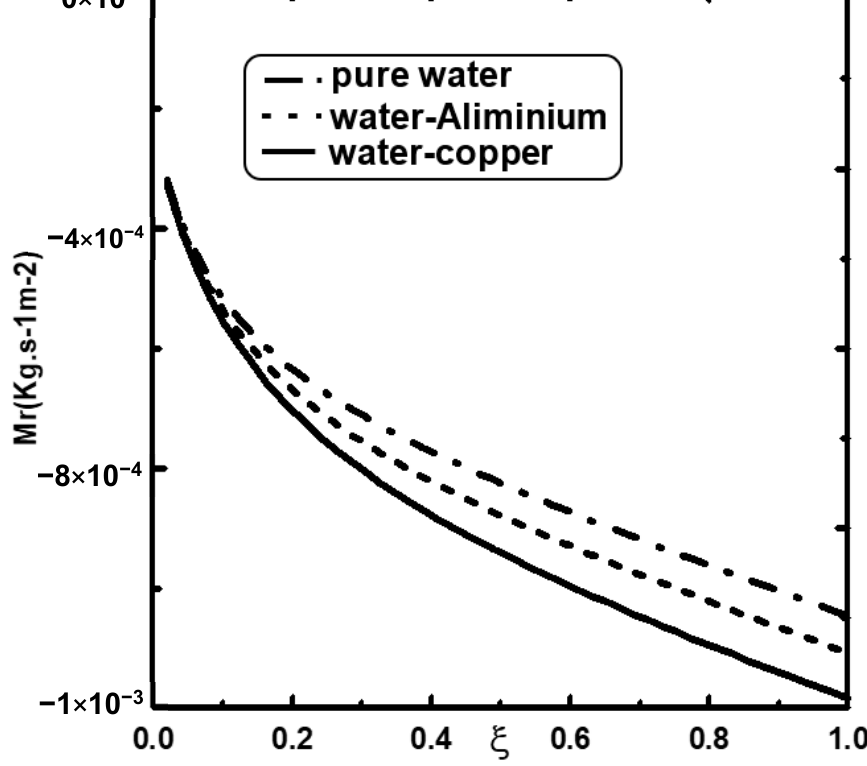
Figure 9. Effect of nanoparticles type on the cumulated condensation rate: T 0 = 293.15 K, T 0L = 293.15 K, q 1 = − 1000 W/m 2 , T w = 293.15 K, Φ 0 = 0.03, c 0 = 0.3, u 0 = 1 m/s, m 0L = 0.015 kg/m.s, H=1 m, d=0.015 m, p 0 =1 atm.